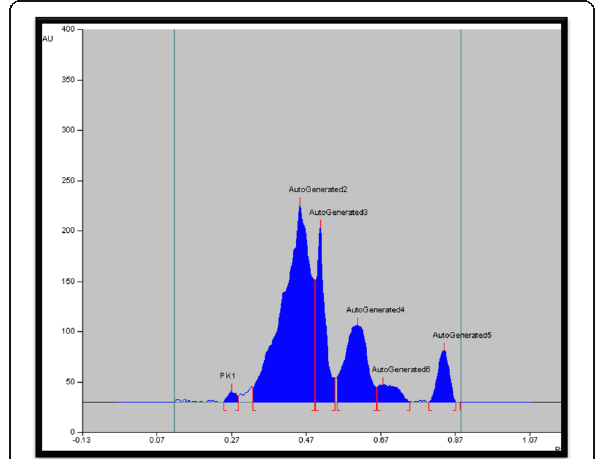
Fig. 3 Profile of ethyl acetate extract of different chemical constituent peaks